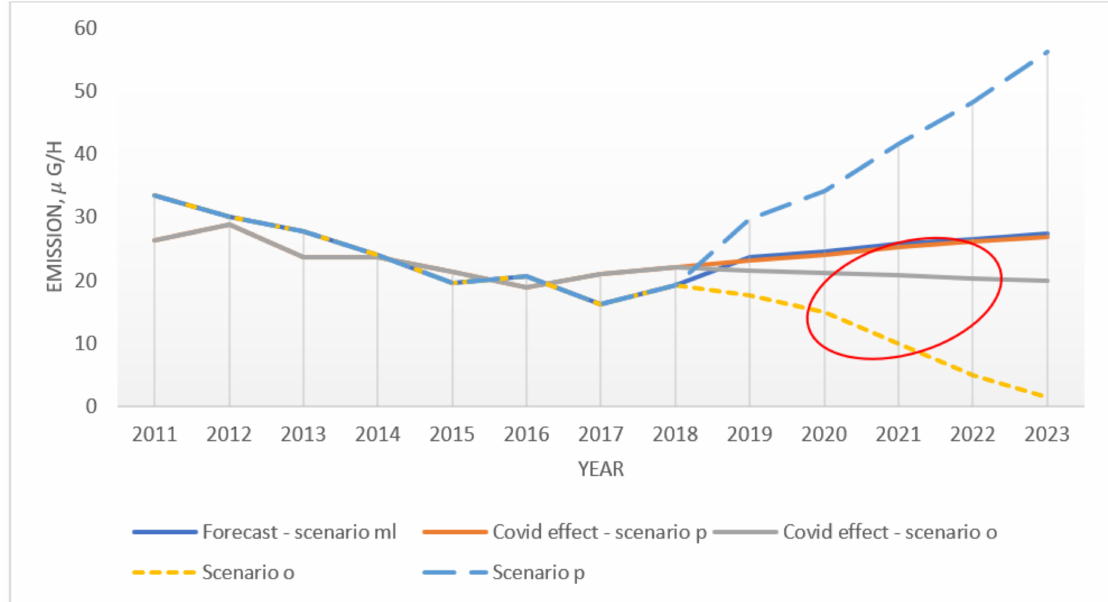
Figure 19. Results of the simulation of the average PM 2.5 emission level in particular years until 2023. Source: Own elaboration, based on data from Copernicus Atmosphere Monitoring Service (CAMS)